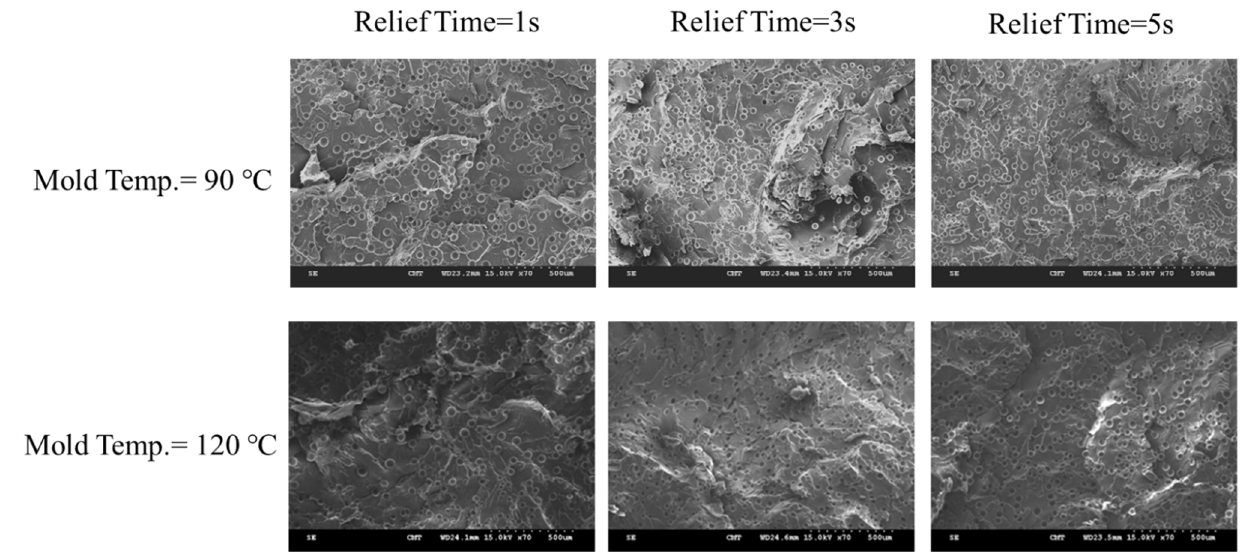
Figure 7. Effect of GCP release speed (relief time) on foaming morphology under two mold temperatures (90 °C and 120 °C).